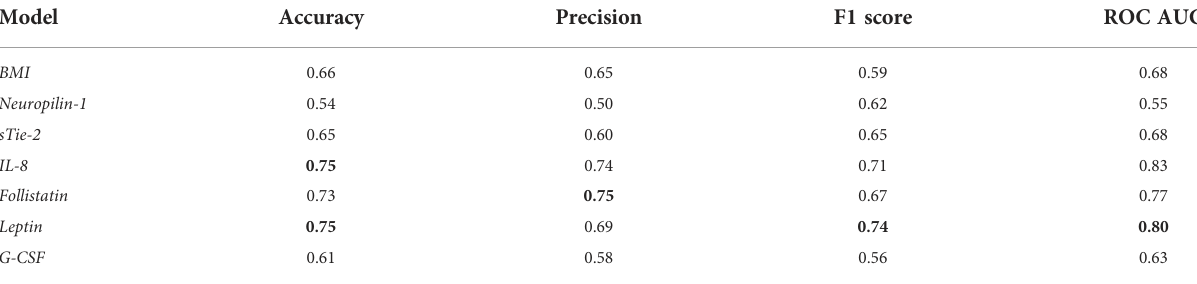
TABLE 3 Performance metrics of univariate models on the training dataset based on single angiogenic factors.